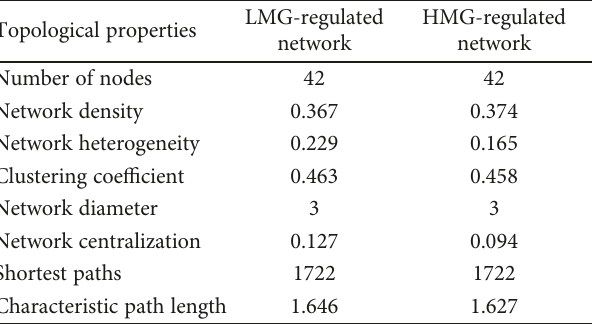
Figure 1: Flowchart of this study. First, LMGs as DMRs with fold_ change < 5th percentile and HMGs as DMRs with fold_ change > 95th percentile were extracted. Second, LMG- and HMG-regulated networks were constructed based on mutual information. Third, the top 10 LMGs and HMGs were extracted as candidate genes. Fourth, for these candidate genes, the Pearson and Spearman correlations were performed to show the association between their methylation levels and clinical phenotype in the network. Finally, some candidates were selected to validate their association with GO in an enlarged population using single-cell methylation sequencing. Table 2: Topological properties of LMG- and HMG-regulated